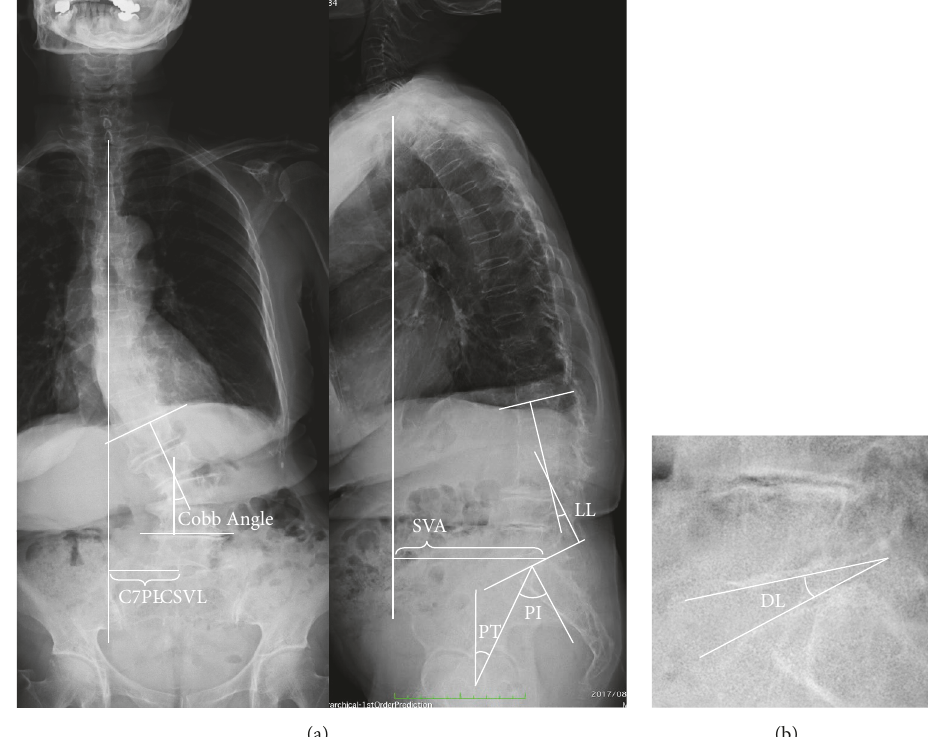
Figure 1: (a) Measurements of sagittal spinal alignment. C7PL-CSVL, C7 plum line to center sacral vertebral line; Cobb angle; SVA, sagittal vertical axis; PT, pelvic tilt; PI, pelvic incidence; LL, lumbar lordosis. (b) DL, disc